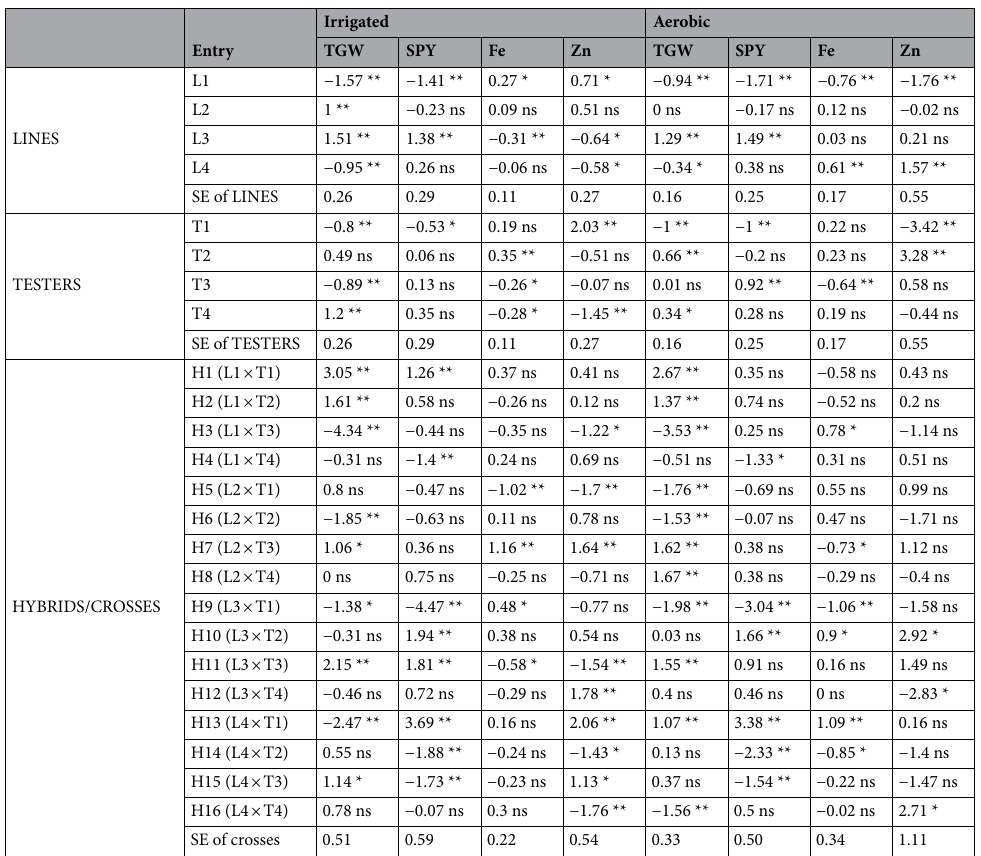
Table 8. Estimation of relative general combining ability (GCA) effects of parents, relative specific combining ability (SCA) effects of crosses (Hybrids) for TGW, SPY, grain Fe and Zn concentration in Irrigated